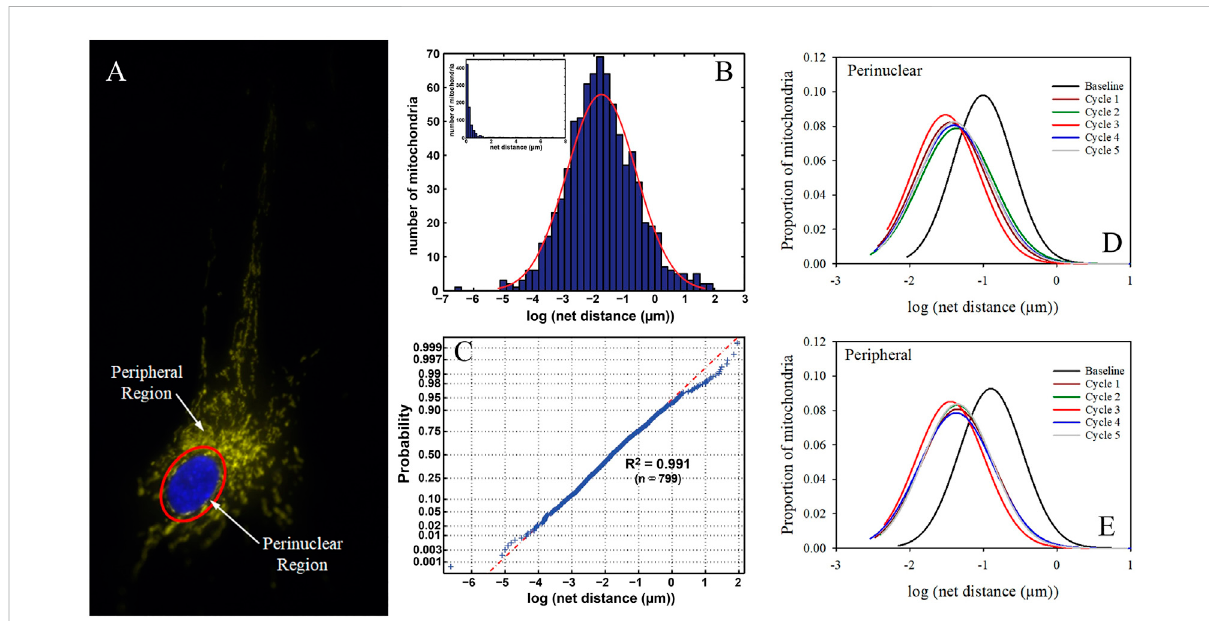
FIGURE 2 Intracellular partitioning of mitochondria and lognormal distribution of mitochondrial motility. (A) The image of a fi broblast shows a nucleus stained with DAPI (blue) and TMRM-stained mitochondria (yellow). The mitochondria are separated into peripheral and perinuclear regions by the image-analysis derived partition (red). (B) Example of distribution of net distances traversed by hundreds of mitochondria on a log scale, with inset showing linear scaling of the same data (Kandel et al., 2015). (C) Normal probability distribution of the log values of net mitochondrial distances traversed indicating that motility follows a lognormal distribution (Kandel et al., 2015). (D) Lognormal distribution of mitochondrial motility in cellular perinuclear region at baseline and following multiple hyperbaric oxygen exposures as detailed in (Green et al., 2021). (E) Lognormal distribution of mitochondrial motility in cellular peripheralregion at baseline and following multiple hyperbaric oxygen exposures as detailed in (Green et al.,